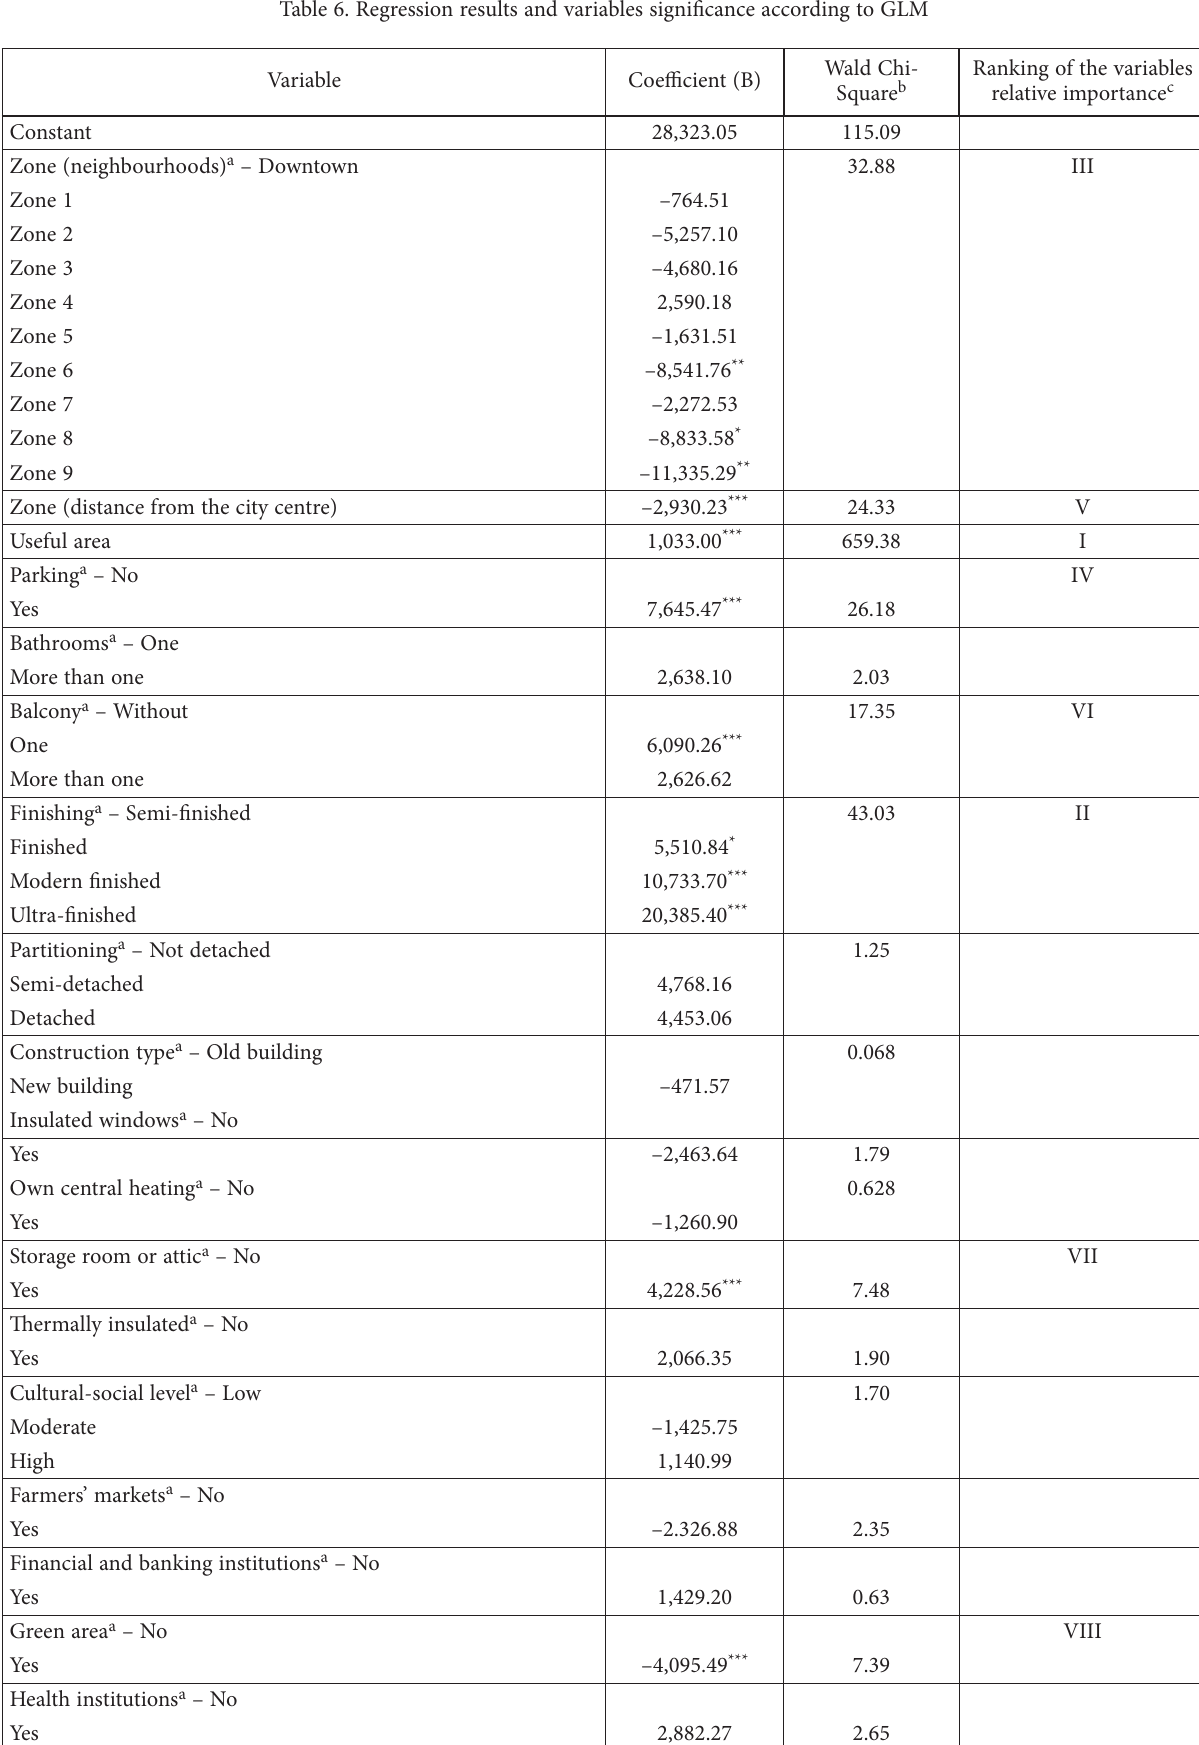
Table 6. Regression results and variables significance according to